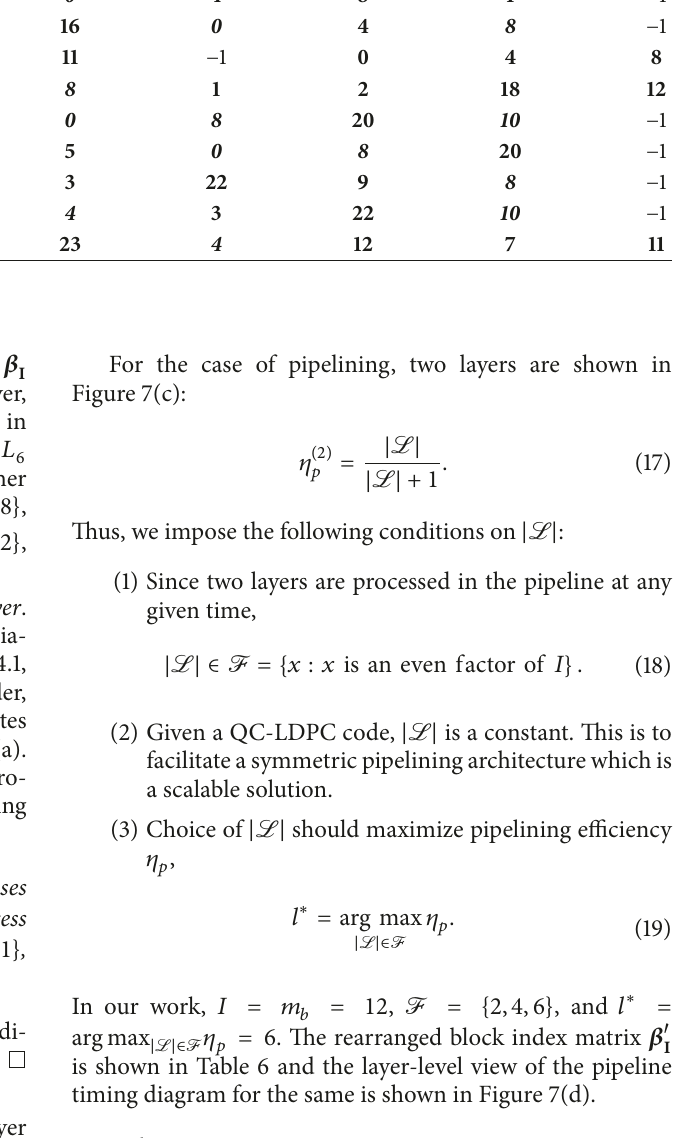
Table 6: Rearranged block index matrix 𝛽 󸀠 𝐼 used for our work, showing the valid blocks (bold) to be processed. Layers ↓ 𝑏 𝑏 𝑏 1 2